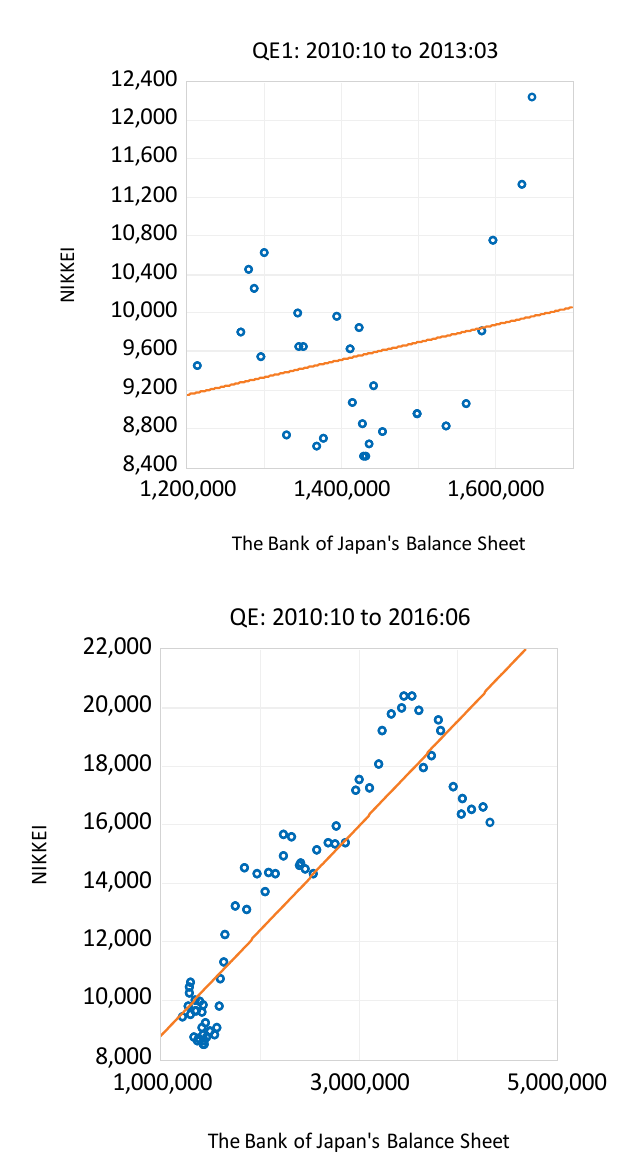
Figure 3. Scatter plot of the NIKKEI 225 against the Bank of Japan’s balance sheet (in millions).